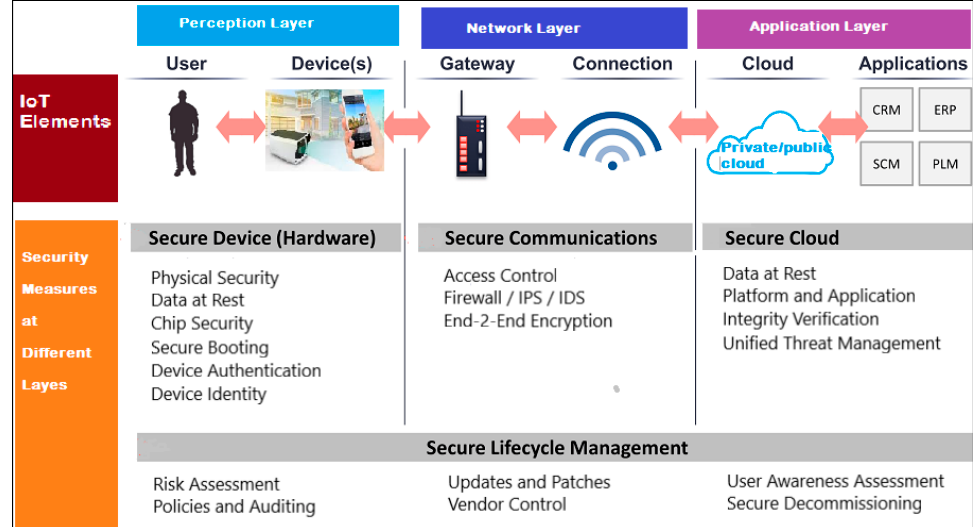
Figure 6. Summarizing the security measures at different layers.